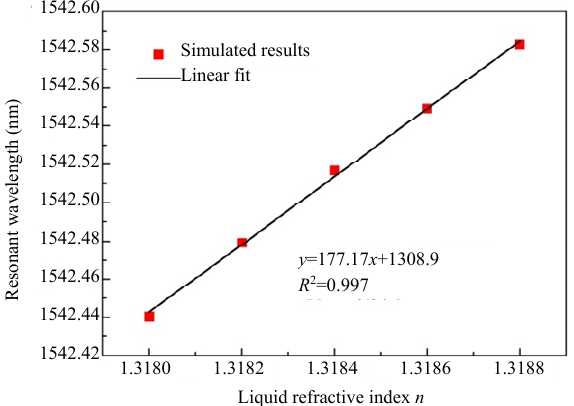
Fig. 10. Resonant wavelength versus refractive index of the tested liquid, and linear fittings are used to calculate the sensitivity of the